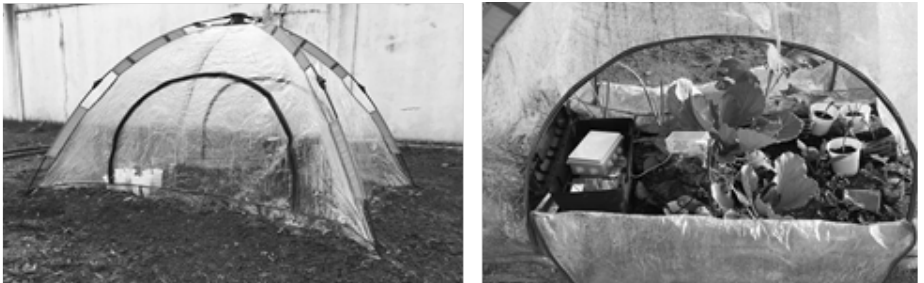
Figure 4. Photographs of the greenhouse used in the SOLL project From the sliding door, some crops were planted and a box with sensors was placed for monitoring. From the sensors placed to monitor the greenhouse, real-time data are obtained that, together with open data feeds, will provide results that will be worked out by the students in the accomplishment of some activities that are in the online platform.